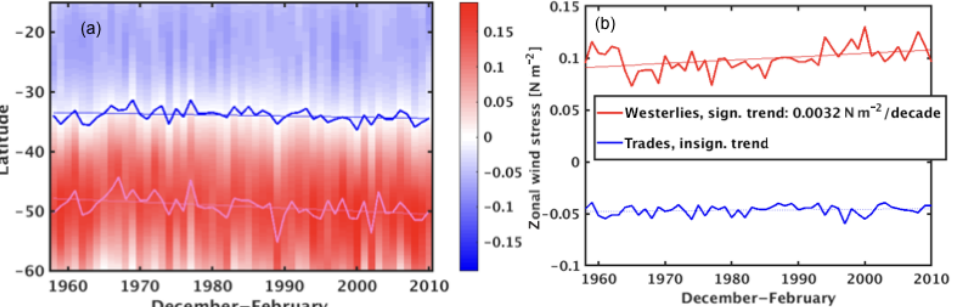
Figure 2. Temporal evolution of zonal mean (40 ◦ W–100 ◦ E) zonal wind stress (Nm − 2 ) (shaded color) and the meridional position of the maximum of the westerlies (light pink curve) and the wind stress curl (blue curve). The linear trends in their positions are also displayed. There is a significant trend of − 0 . 52 ◦ per decade in the position of the westerlies and an insignificant trend for the trades (a) . The temporal evolution of the intensity of wind stress for the westerlies (mean between 60 ◦ S and of the latitude at which wind stress turns eastward) and trades (mean between latitude at which wind stress turns eastward and 15 ◦ S) and their corresponding linear trends (b) , both in December– February as derived from the COREv2 data set in the period 1958–2009.